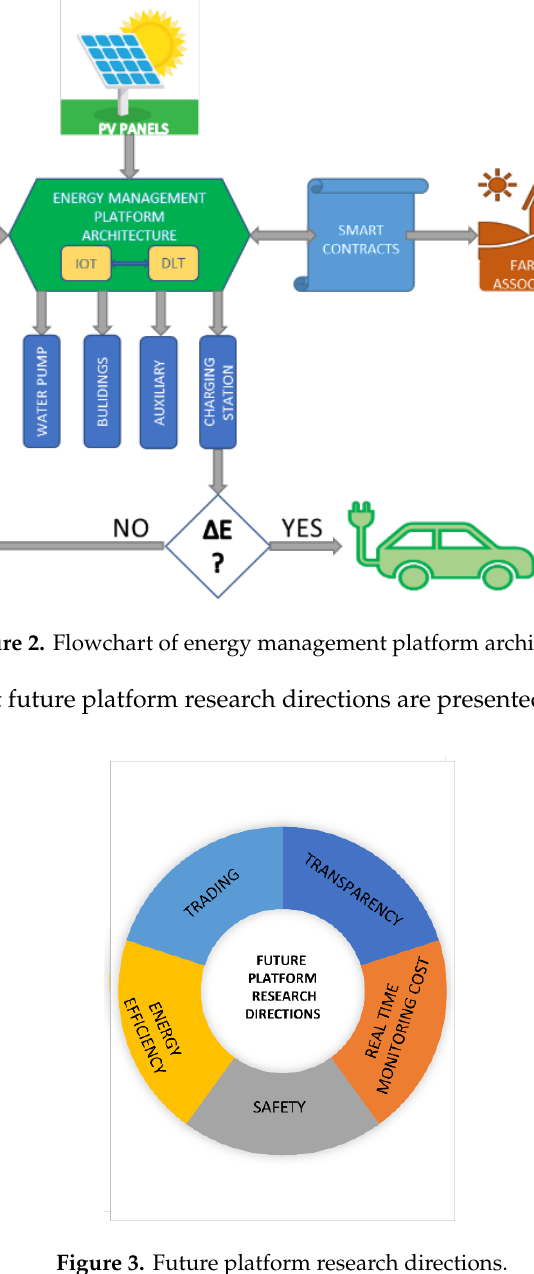
Figure 3. Future platform research directions.